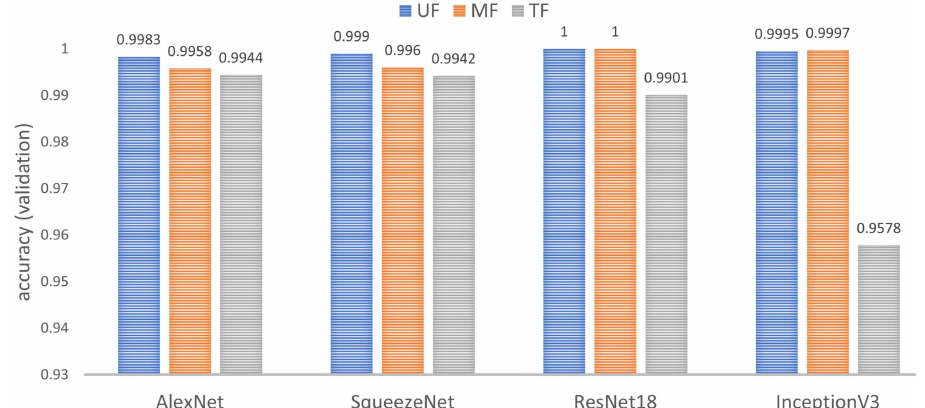
Figure 15. Comparison of four TL-based models in terms of Freezing Point. UF (not frozen weights), MF (medium freezing point), TF (totally frozen, except for the last FC layer).